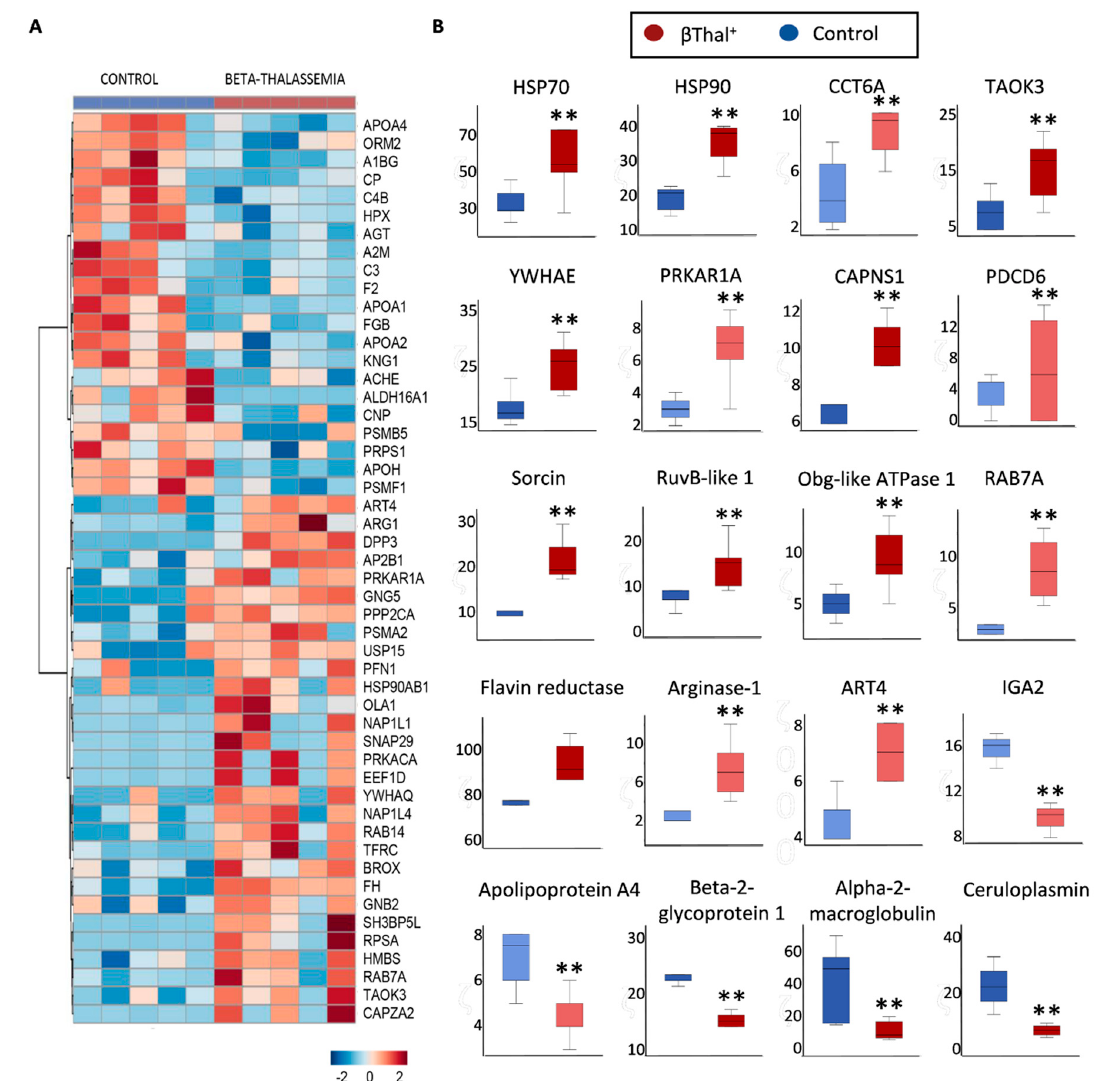
Figure 9. Proteomics analysis of storage EVs. ( A ) Heat map for proteins differing between β Thal + and control vesicles ( n = 5 per group). ( B ) Representative boxplots showing statistically significant variation in the levels of specific EV proteins between the two groups. Light and dark colors indicate proteins of low and high abundance, respectively. (**) p < 0.05 and fold > 1.25 β Thal + vs. controls. Abbreviations: CCT6A: T-complex protein 1 subunit zeta; TAOK3: serine/threonine-protein kinase; YWHAE: 14-3-3 protein epsilon; PRKAR1A: cAMP-dependent protein kinase type I-alpha regulatory subunit; CAPNS1: calpain small subunit 1; PDCD6: programmed cell death protein 6; ART4: ecto-ADP-ribosyltransferase 4; IGA2: immunoglobulin alpha-2 heavy chain.